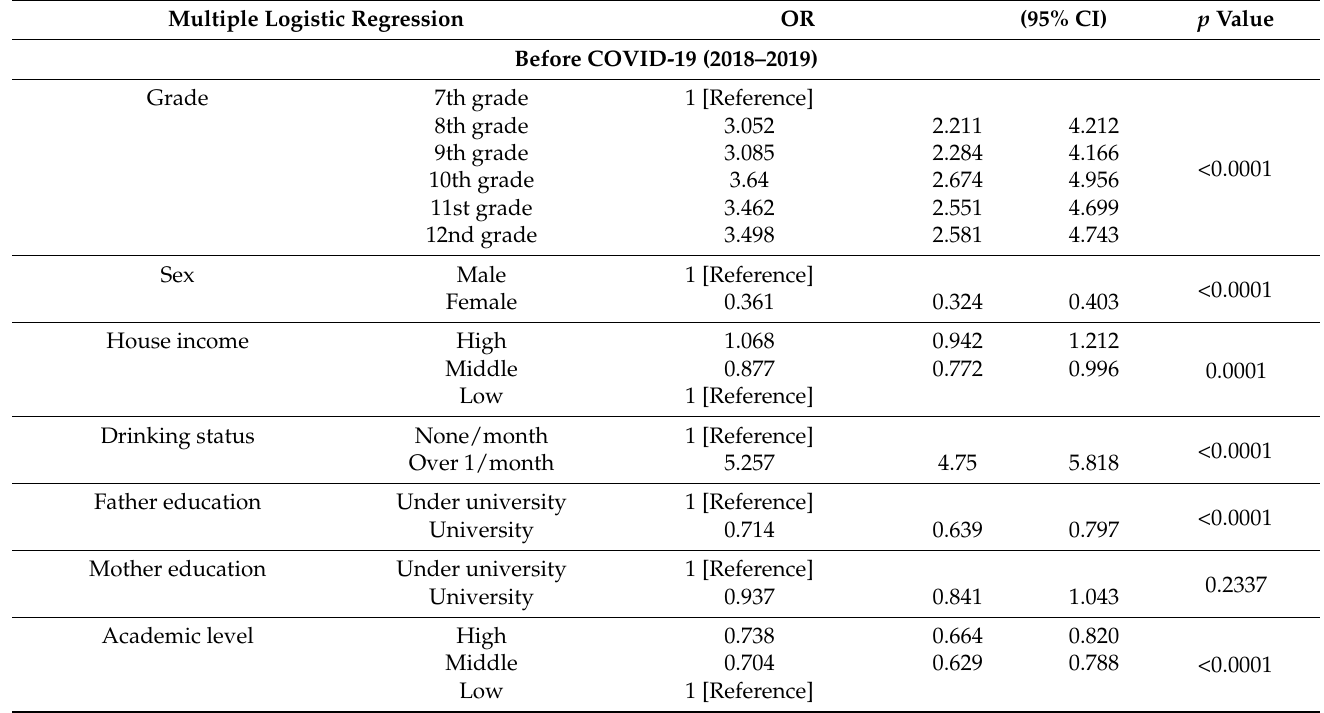
Table 4. Prevalence of E-Cigarette’s Smoking Before and During